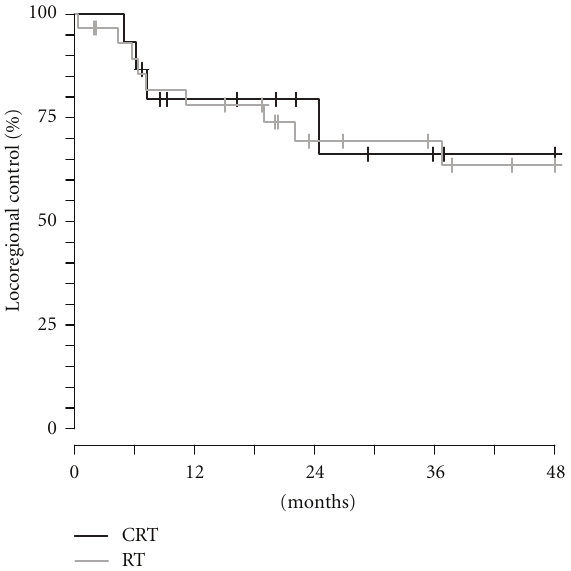
Figure 2: Rates of locoregional control in chemoradiotherapy (CRT) and radiotherapy alone (RT) treated